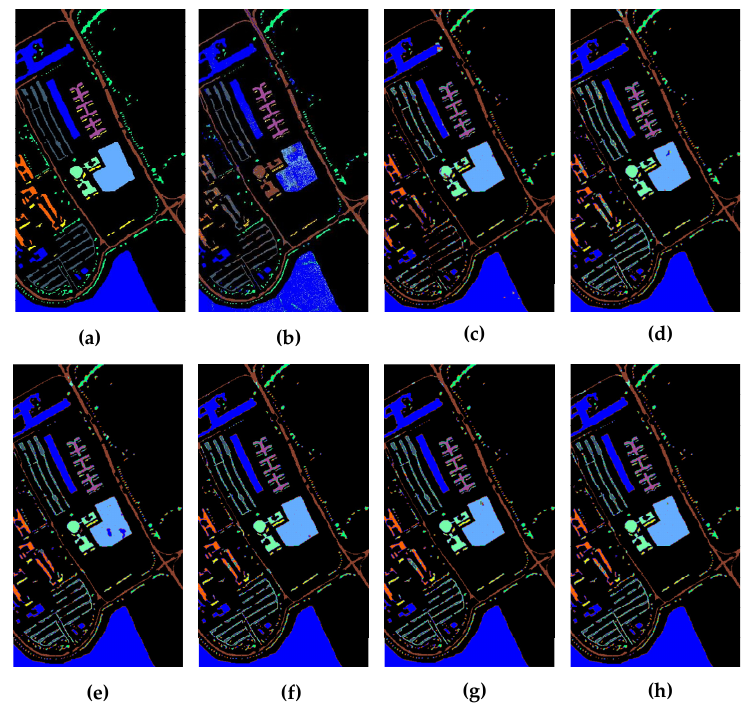
Figure 20. Classification maps acquired by each method for the Indian Pines dataset: ( a ) ground-truth image, ( b ) SVM, ( c ) 2DCNN, ( d ) 3DNN, ( e ) SSRN, ( f ) HybridSN, ( g ) SSAN, ( h ) proposed TSSFAN.